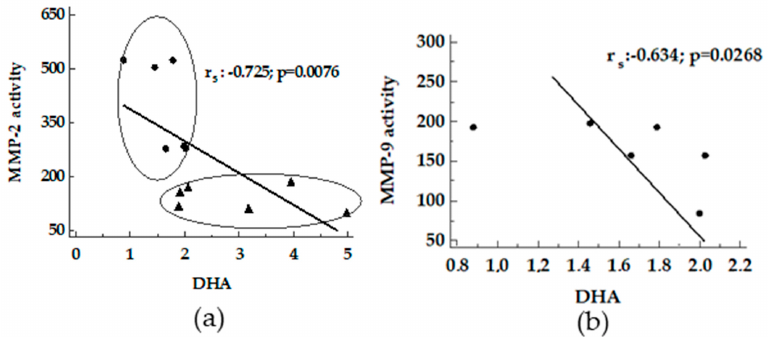
Figure 6. Correlation between DHA and MMPs in livers from MCD and Obese Zucker rats. Panels a , Figure 6 DHA versus MMP-2 activity; panels b , DHA versus MMP-9 activity. • : MCD rats; (cid:78) : Obese Zucker